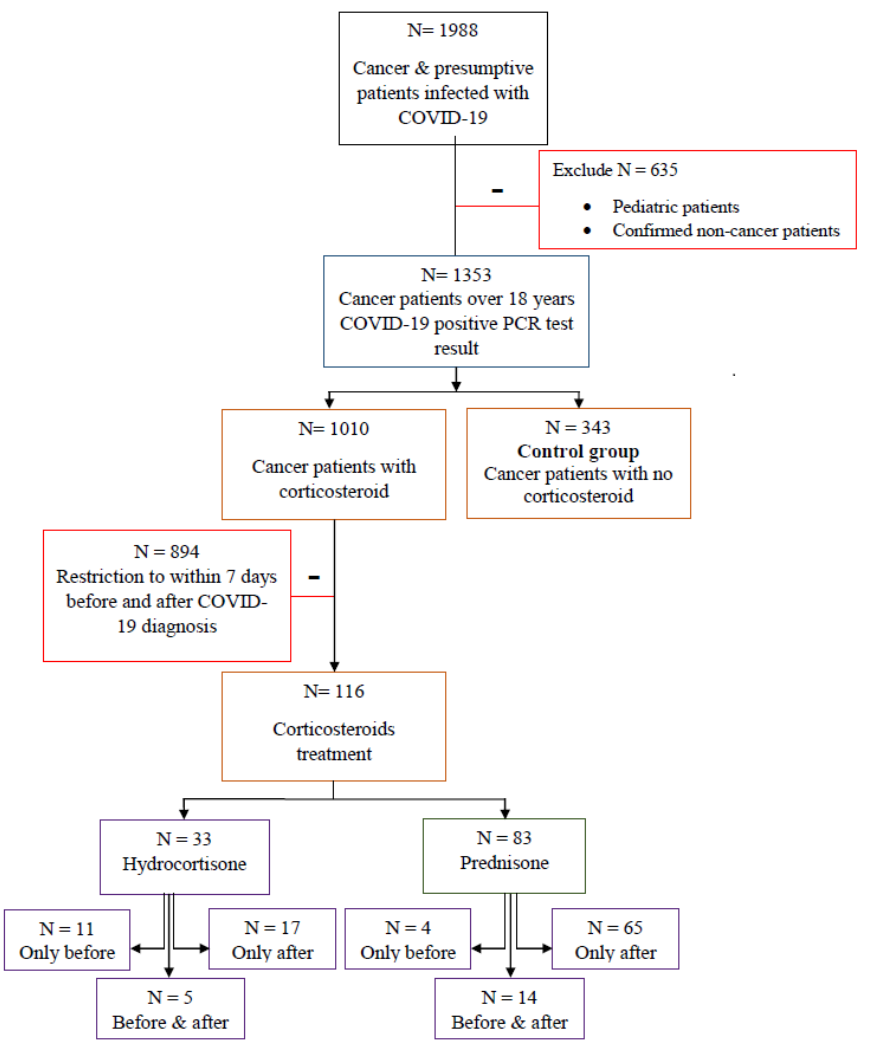
Figure 1. Methodology outline, including selection and rejection criteria.